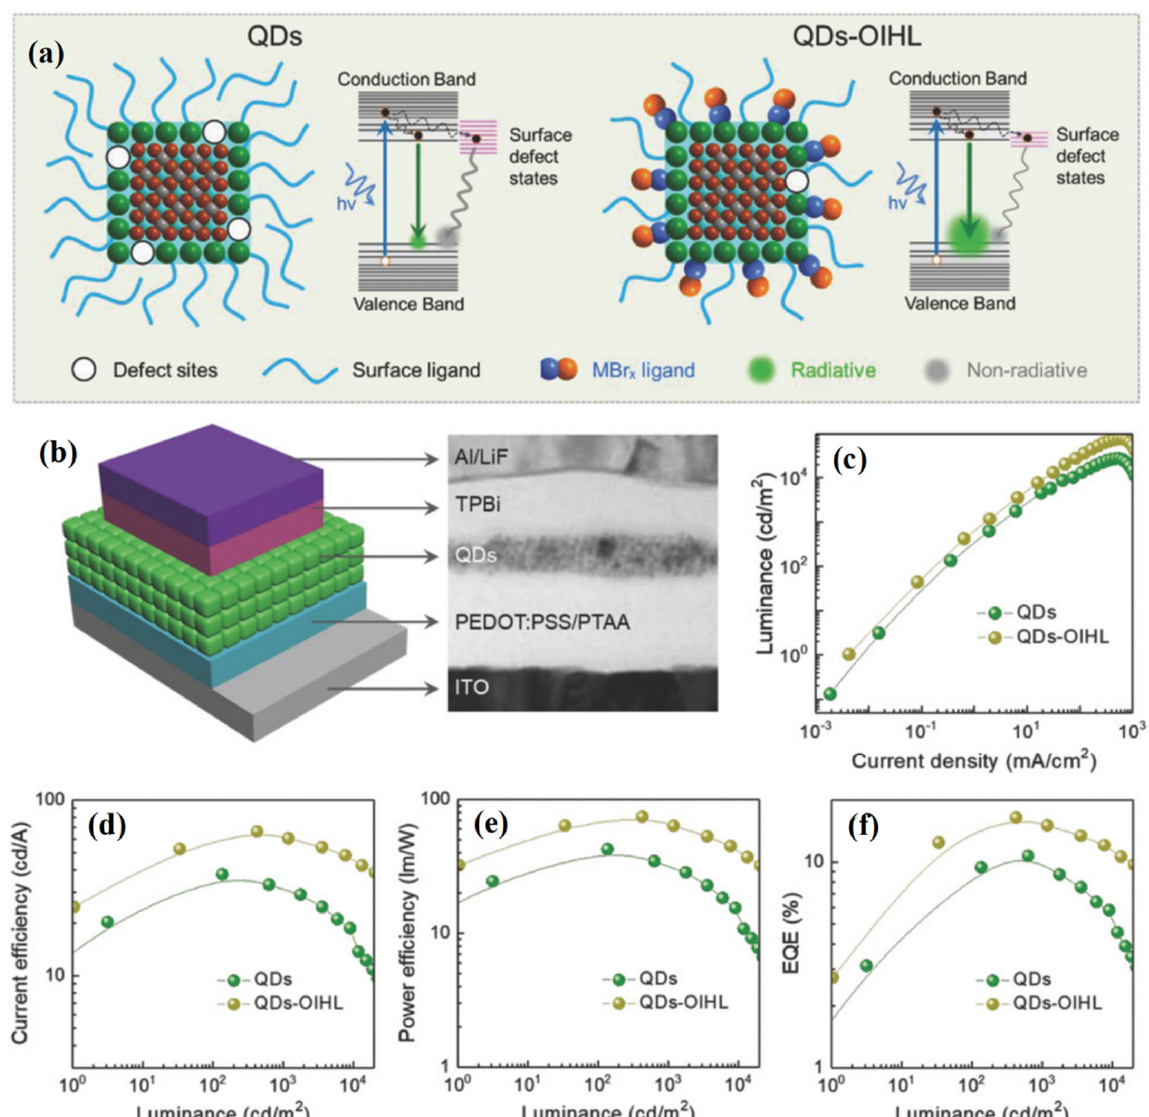
Figure 11. ( a ) Schematic of radiative/nonradiative recombination of PQDs with and without OIHL. ( b ) Illustration of multilayer PeQLED device and cross-sectional TEM image. ( c – f ) Luminance, CE, PE, and EQE of the devices. Reproduced with permission from [82]. Copyright 2018, Wiley.